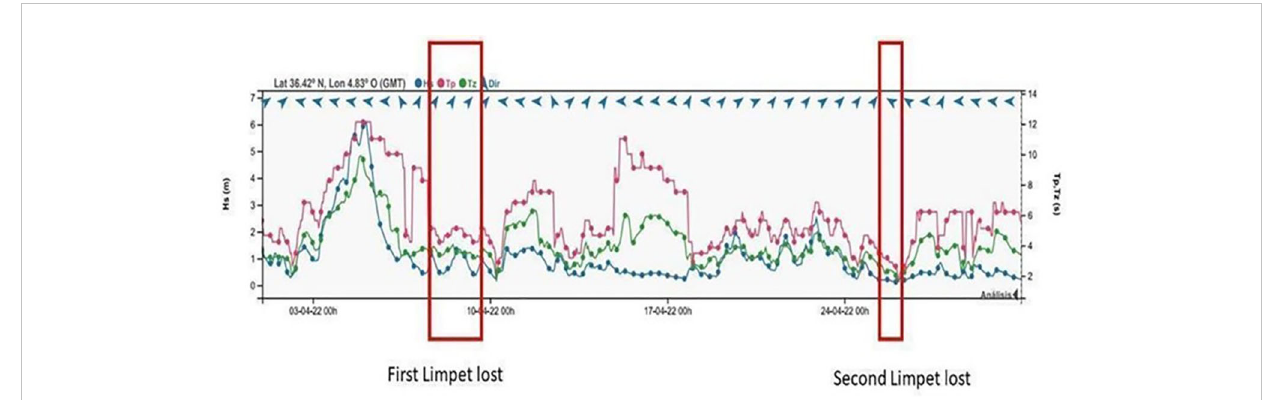
FIGURE 6 Maximum swell recorded during the study period ( fi rst week of April 2022), after which there was only the immediate loss of a single relocated limpet and a subsequent one 15 days later.